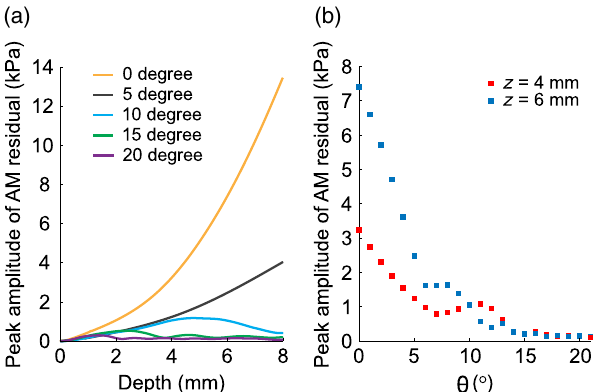
FIG. 3. Simulation of nonlinear plane-wave interaction as a function of the cross-propagation angle θ . (a) Peak positive pressure of the xAM residual as a function of depth for five cross- propagation angles. (b) Peak positive pressure of the xAM residual as a function of θ at depths z equal to 4 mm and 6 mm.